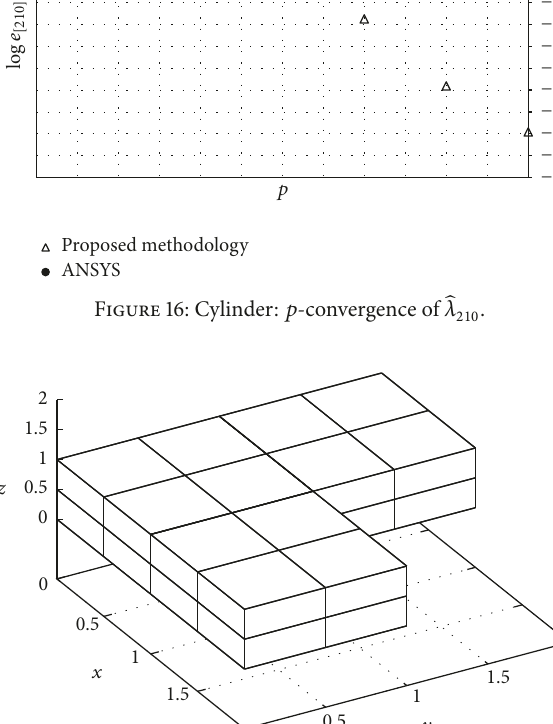
Figure 17: L-shaped prismatic cavity.